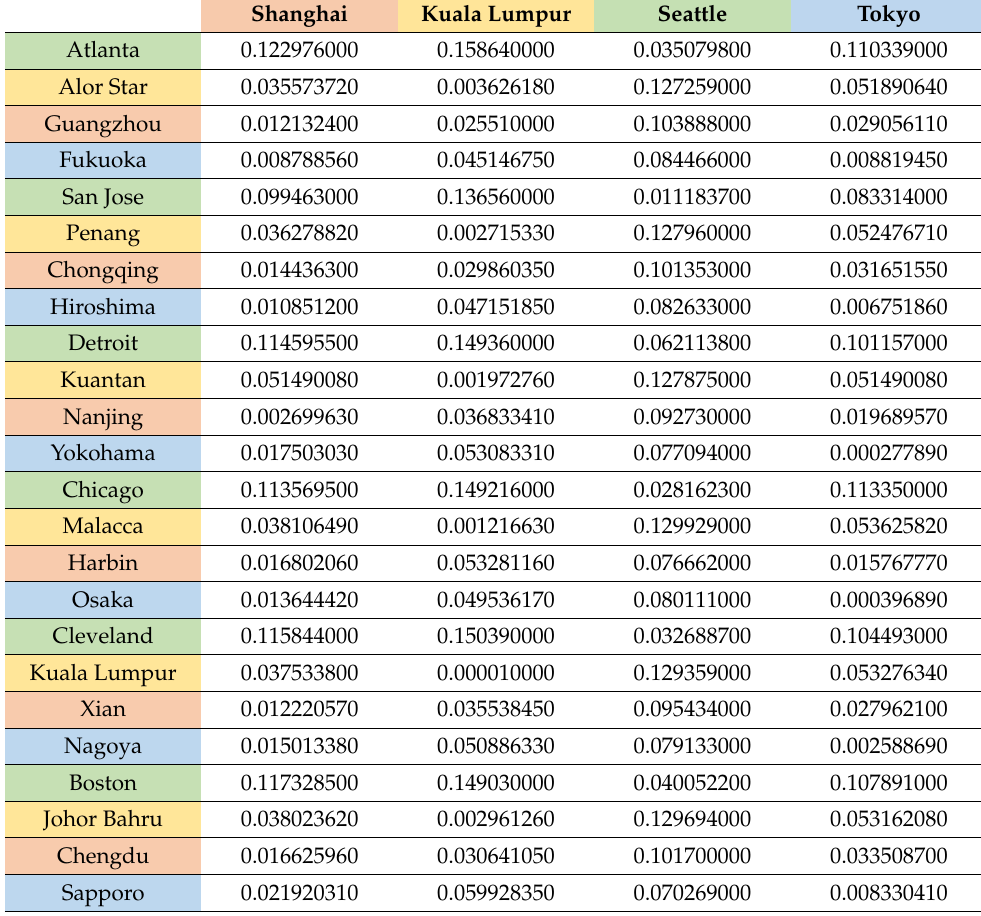
Table A1. Transportation costs of parts between cities